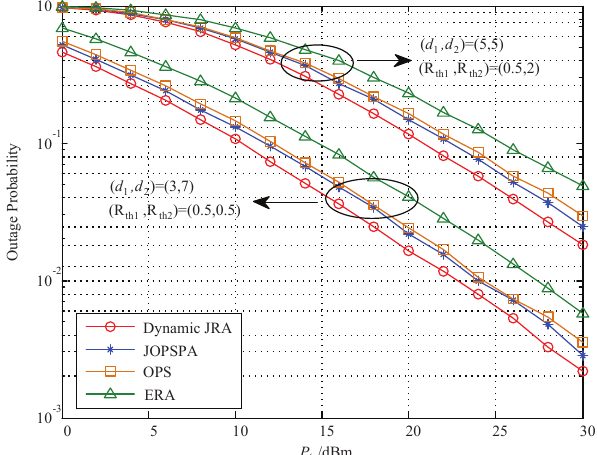
Figure 6. Outage probability vs. P t based on instantaneous CSI.